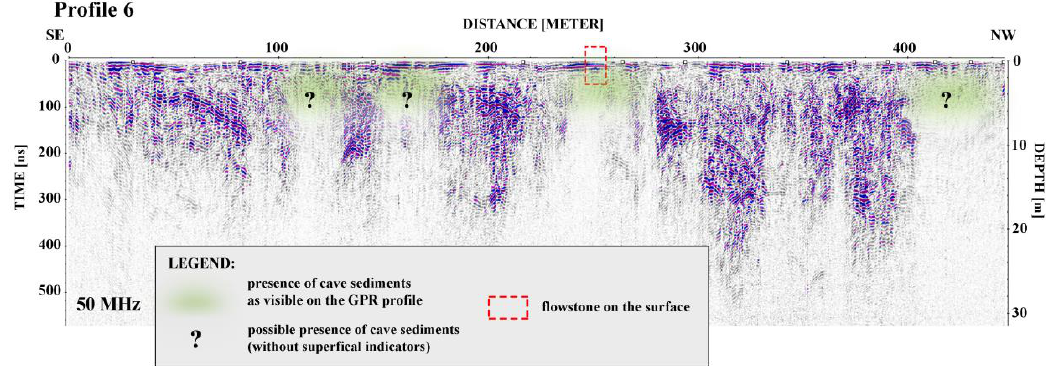
Figure 14. The radargram of Profile 6 with four detected attenuated areas. Flowstone only occurs on the surface at one location, so other locations were interpreted as “possible locations of cave sediments” (see legend). The attenuated area at the distance of 155 – 170 m corresponds to the direction of the cave sediments extent detected in Profile 3.